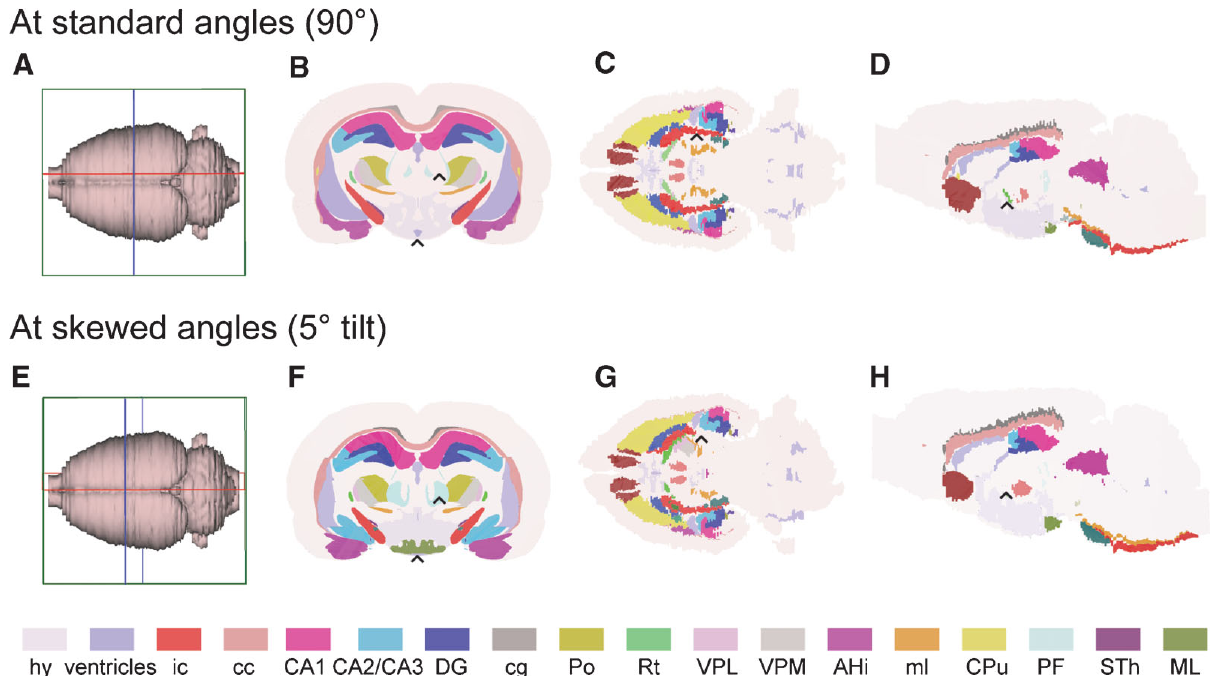
Figure 3. Customized atlas diagrams . Series of customized, color coded coronal ( B, F ), horizontal ( C, G ), and sagittal ( D, H ) atlas diagrams, generated using the slicing and filling module in the atlas tool. Blue, red, and green bounding boxes in ( A, E ) indicate the levels from which the respective slices were obtained. ( A–D ) Standard orientation of atlas slices, oriented perpendicularly to axes of the stereotaxic coordinate system. ( E–H ) Example of atlas slices cut at non-standard angles, tilted 5degrees from the planes used in ( B–D ). Black arrow heads indicate examples of structural differences between the corresponding diagram pairs, emphasizing the importance of having atlas diagrams with similar orientation as experimental slices. hy, hypothalamus, whole region; ic, internal capsule; cc, corpus callosum; CA1, field CA1 of the hippocampus; CA2/CA3, field CA2 and CA3 of the hippocampus; DG, dentate gyrus; cg, cingulum; Po, posterior thalamic nucleus; Rt, reticular thalamic nucleus; VPL, ventral posteromedial thalamic nucleus; VPM, ventral posterolateral thalamic nucleus; AHi, amygdalohippocampal area; ml, medial lemniscus; CPu, caudate putamen; PF, parafasicular thalamic nucleus; STh, subthalamic nucleus; ML, medial mammillary